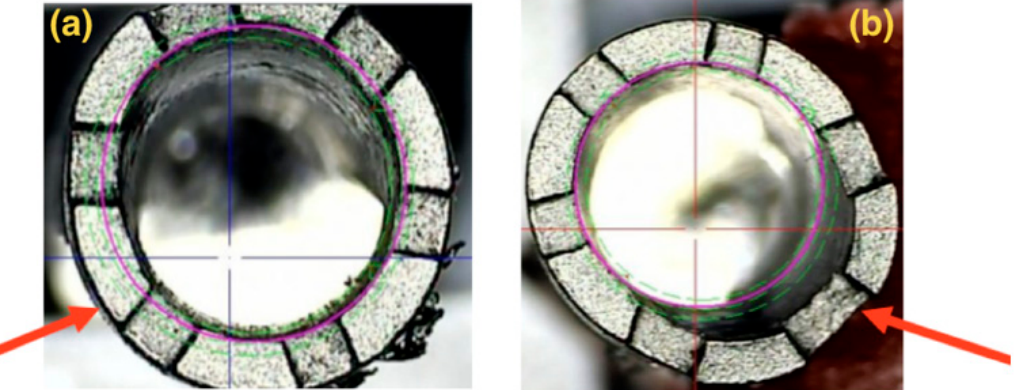
Figure 8. Illustrative images showing the implant superimposition of Groups 3 ( a ) and 4 ( b ) on the profilometer, in which distortion is identified on the platform of each implant after the abutment removal (indicated by the arrows).